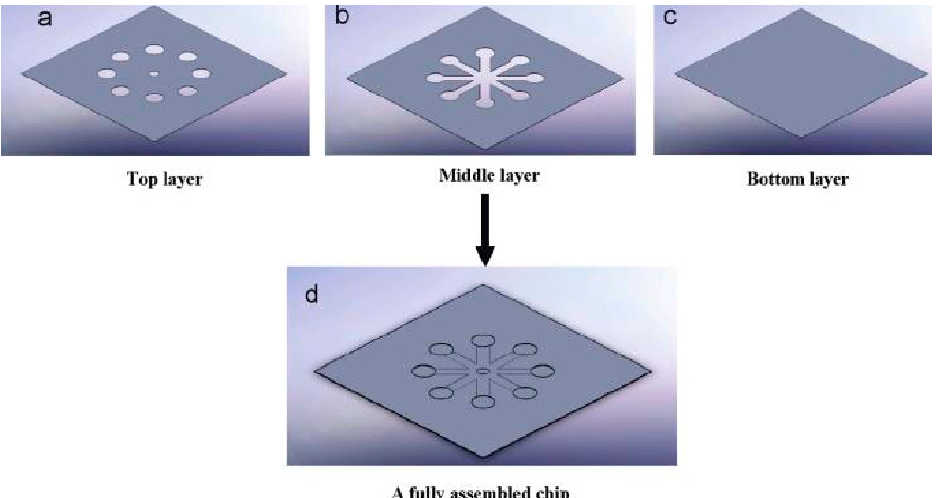
Figure 13. A high throughput eight chamber microfluidic chip composed of polymethylmethacrylate (PMMA), polycarbonate PC and pressure sensitive adhesive (PSA) and manufactured using laser micromachining The top layer (a), middle layer (b), and bottom layer (c) are assembled into a composite chip in (d). Taken with permission from [120].